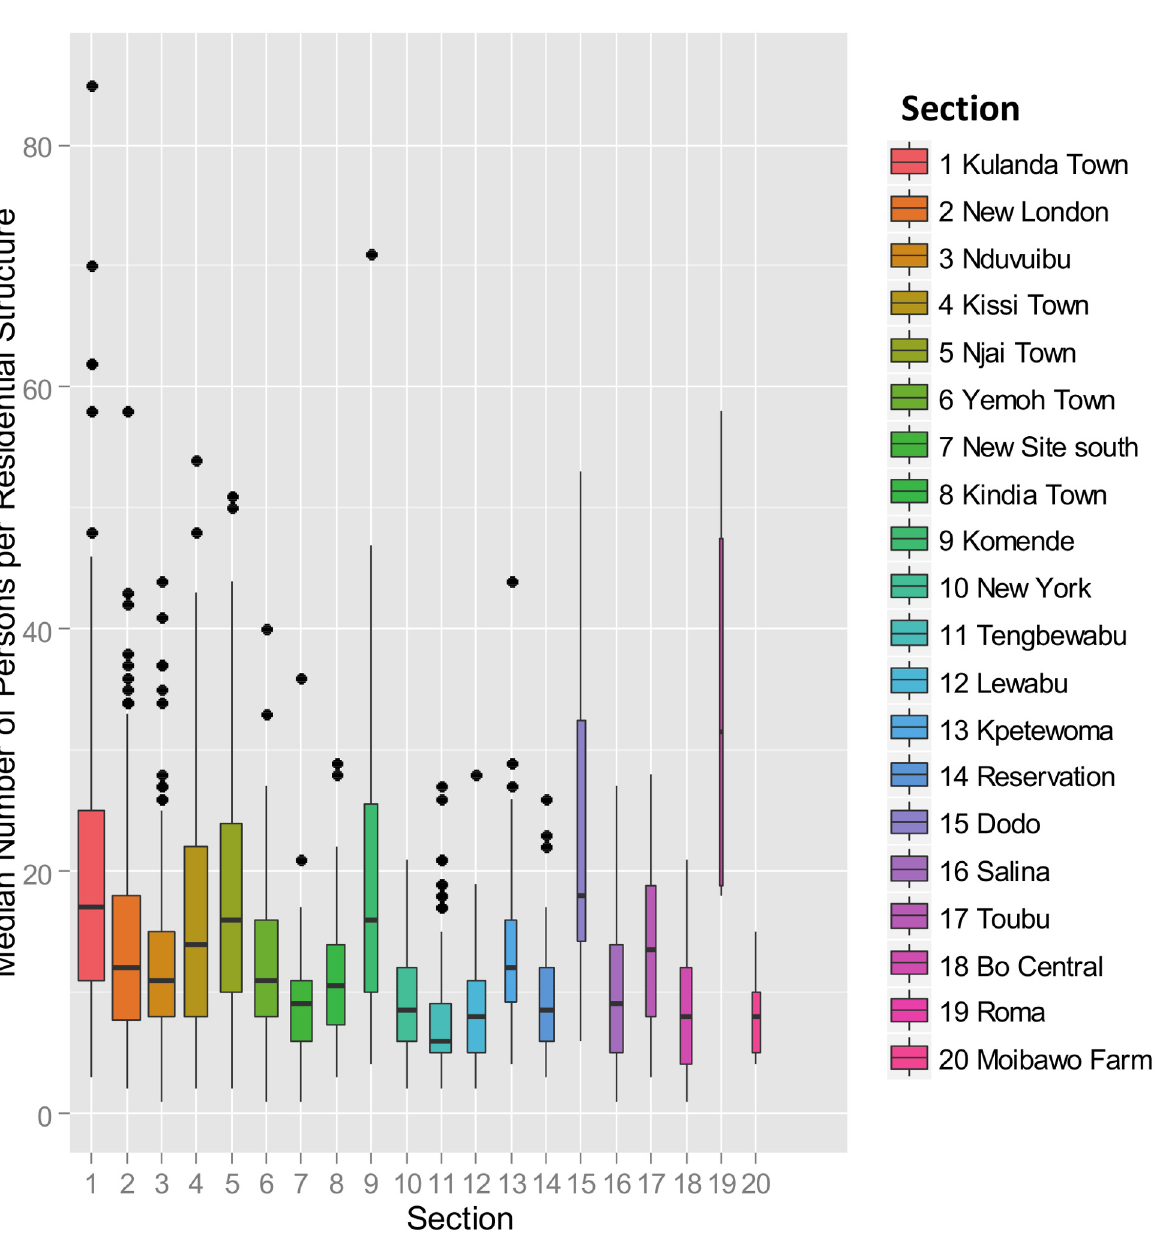
Fig 4. Quantile boxplots for each of the 20 sections. For each section, a quantile boxplot (0.25, 0.75) shows the distribution of the number of persons per residence, arranged in descending order of total section population. The bar in each box is the median value, while outliers deviating by one or more quantiles from the median are denoted as discrete points. The width of each box is proportional to the square root of the number of residential structures (i.e., records) in the section. Roma is an anomaly with 4 residential structures, and 139 total